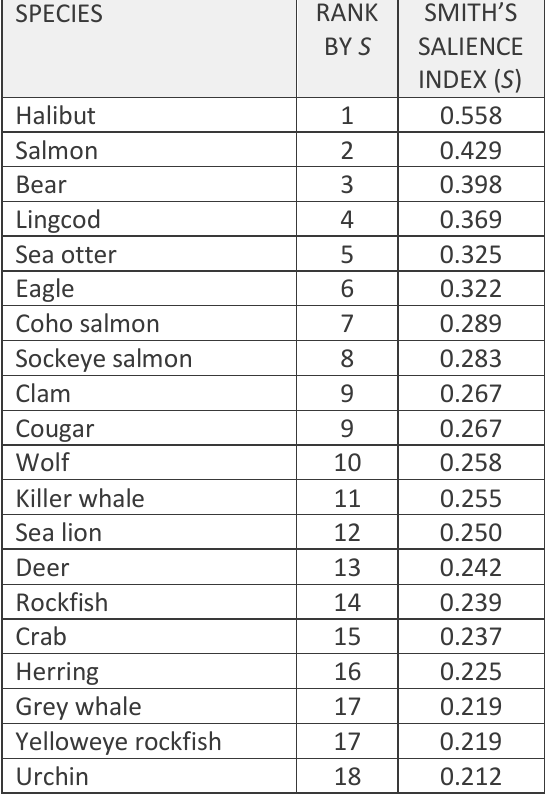
Table (cid:4)(cid:1008) .3 Most cognitively accessible species: females (top 20)